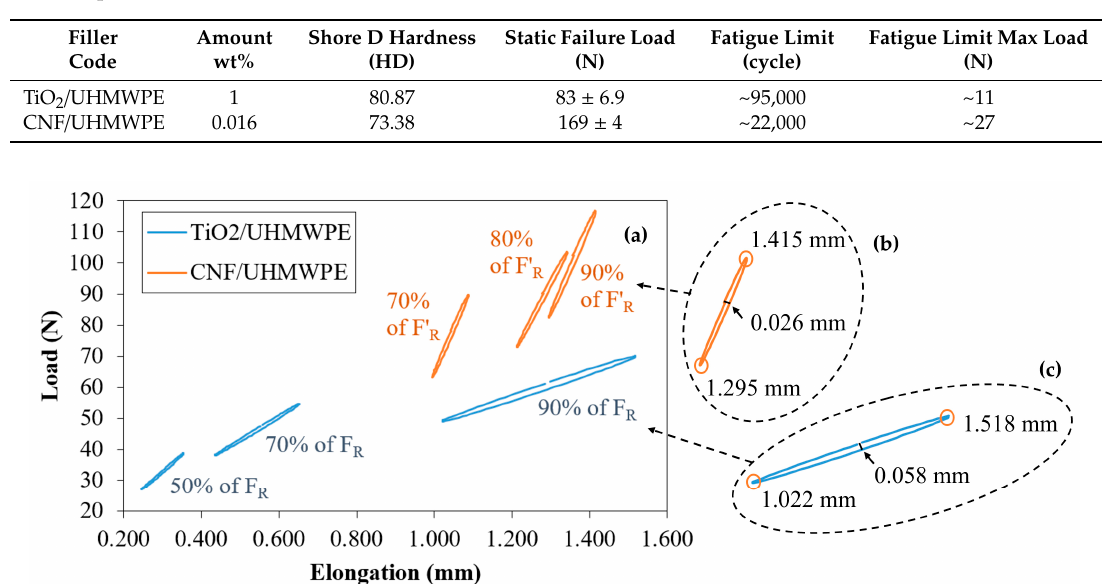
Table 3. Comparison of the static and dynamic performance of the TiO 2 / UHMWPE and CNF / UHMWPE samples. The values of the fatigue properties are indicative. CNF / UHMWPE dynamic characterization is reported in [21].